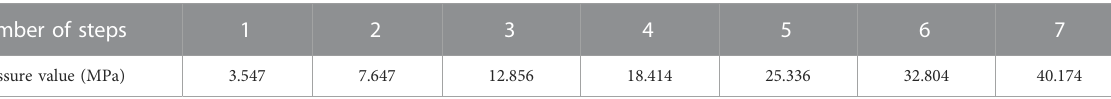
TABLE 3 Value of pressure on the upper and lower semicircular beams.